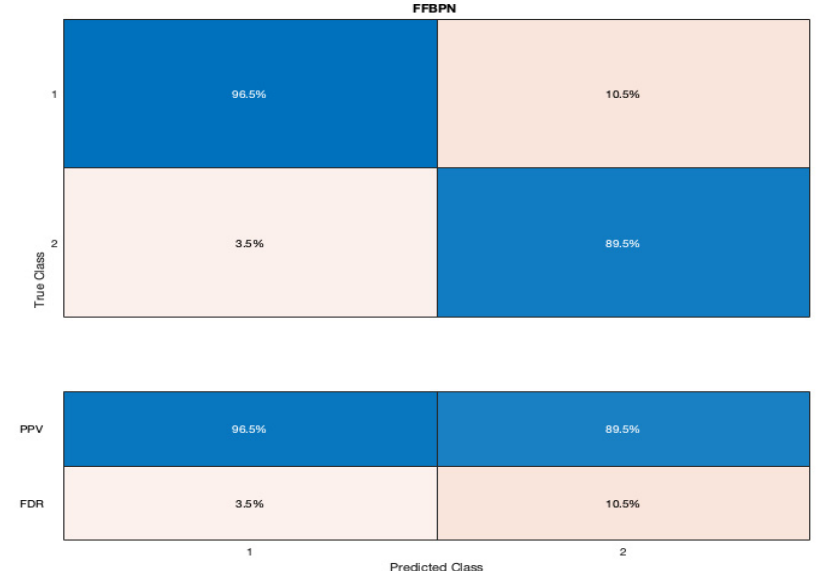
Figure 4. Graphic representation of the confusion matrix with the positive predictive values (PPV) and false discovery rates (FDR) for the prediction of SGA newborns (listed here as 2) when using a Feed-Forward Back Propagation Network (FFBPN).